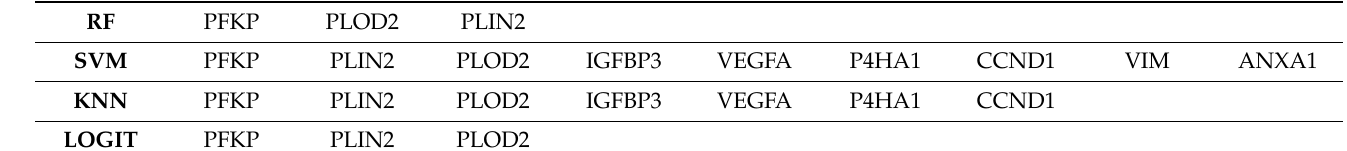
Table 5. Summary table of ideal gene panels in each algorithm. KNN: k-nearest neighbors, RF: random forest, LOGIT: logistic regression, and SVM: support vector